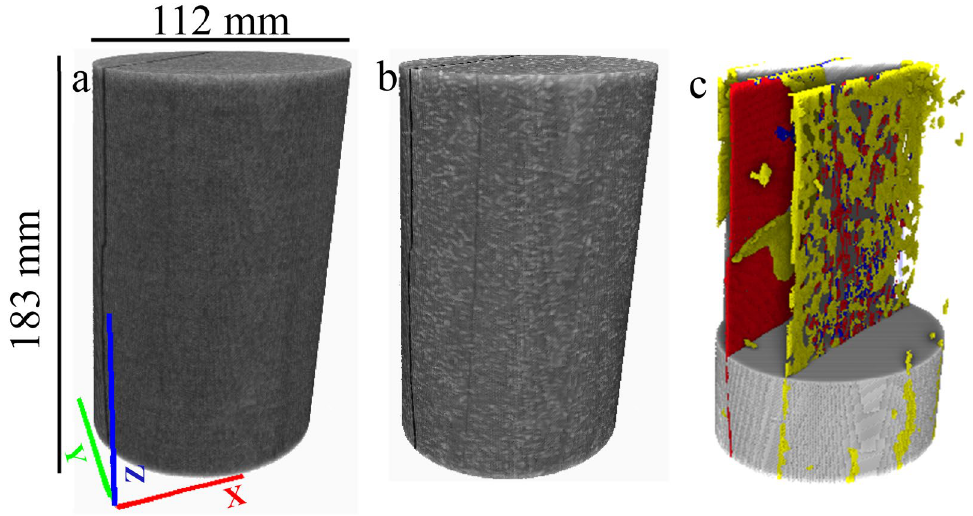
Figure 2. 3D representations of ORS: ( a ) the greyscale neutron tomography image (black = fractures/micro- fractures, grey = solid matrix, ( b ) the grey-scale µ-CT image (black = fractures/micro-fractures, grey and white = organic and inorganic minerals), and ( c ) segmented image (grey = solid phase, red: empty fractures, blue = fluid-saturated fracture spaces and yellow = liquid diffused into the matrix adjacent to